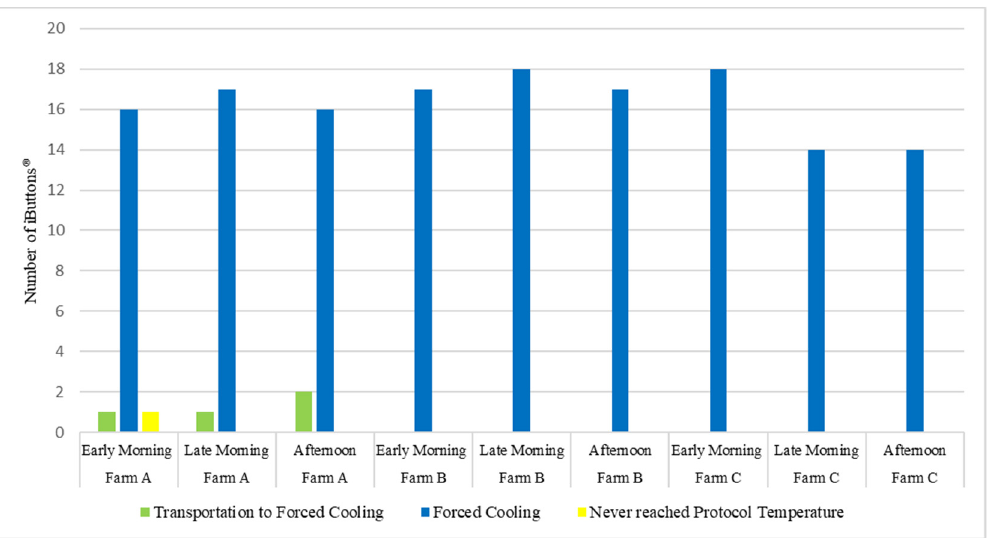
Figure 12. Stage during which PT = 0 °C was reached on Western Cape farms. Source: [13].